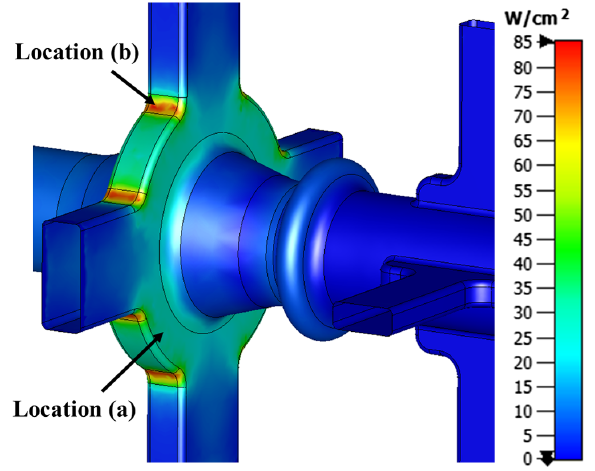
FIG. 14. Steady-state heat load resulting from the 670-W TM 01 incident rf power and the 55-GHz trapped mode for a 20-kHz repetition rate beam.